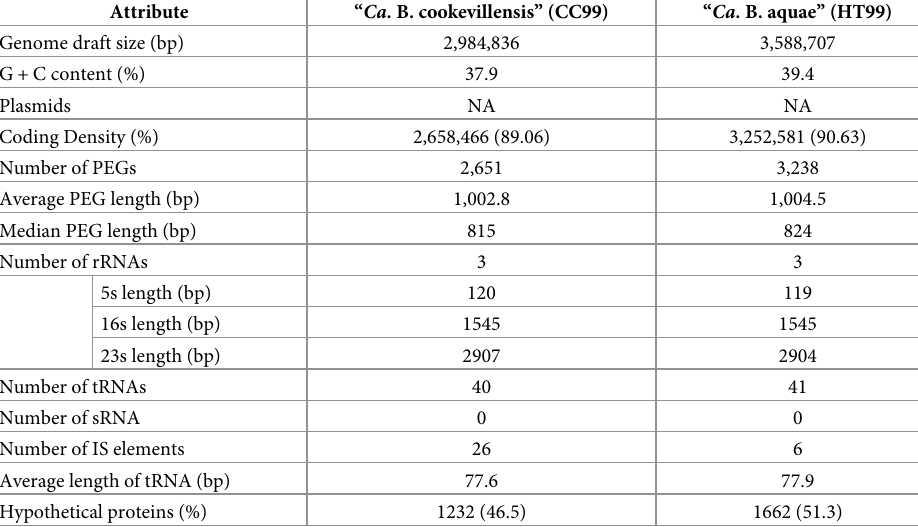
Table 1. General genome features of the “ Ca . B. cookevillensis” and “ Ca . B. aquae”.